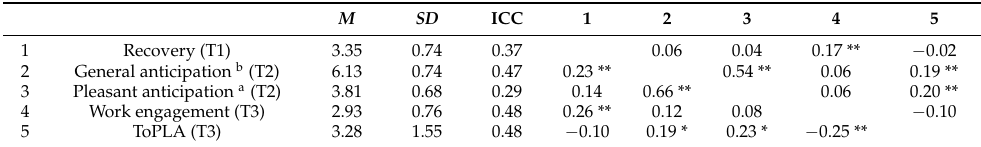
Table 1. Means ( M ), standard deviations ( SD ), and correlations of the study variables. M SD ICC